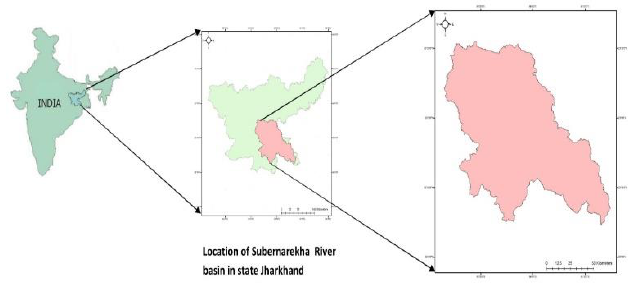
Figure 1: Location of Subarnarekha River basin in state Jharkhand, India